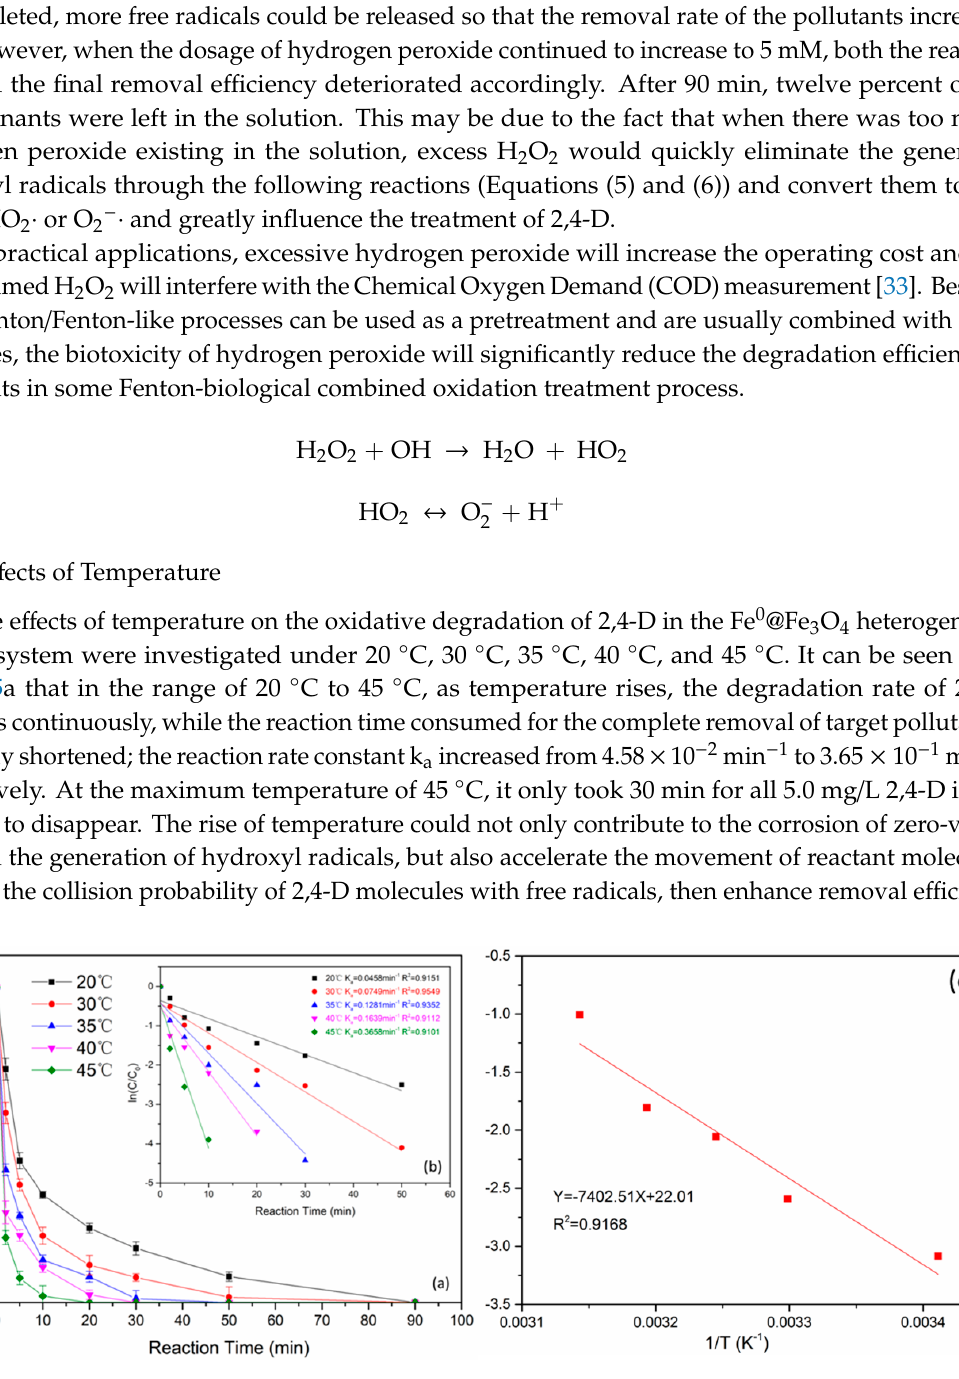
Figure 5. ( a ) Effect of temperature on 2,4-D degradation. ( b ) Dynamic simulation of 2,4-D degradation under different temperatures. ( c ) Fitting curve of ln(K)/T ([2,4-D] 0 = 5.0 mg/L, under di ff erent temperatures. ( c ) Fitting curve of ln(K) / T ([2,4-D] 0 = 5.0 mg / L, [Fe 0 @Fe 3 O 4 ] 0 = 0.5 g / L, [Fe 0 @Fe 3 O 4 ] 0 = 0.5 g/L, H 2 O 2 = 1 mM, pH = 5.0 ± 0.2). H 2 O 2 = 1 mM, pH = 5.0 ±